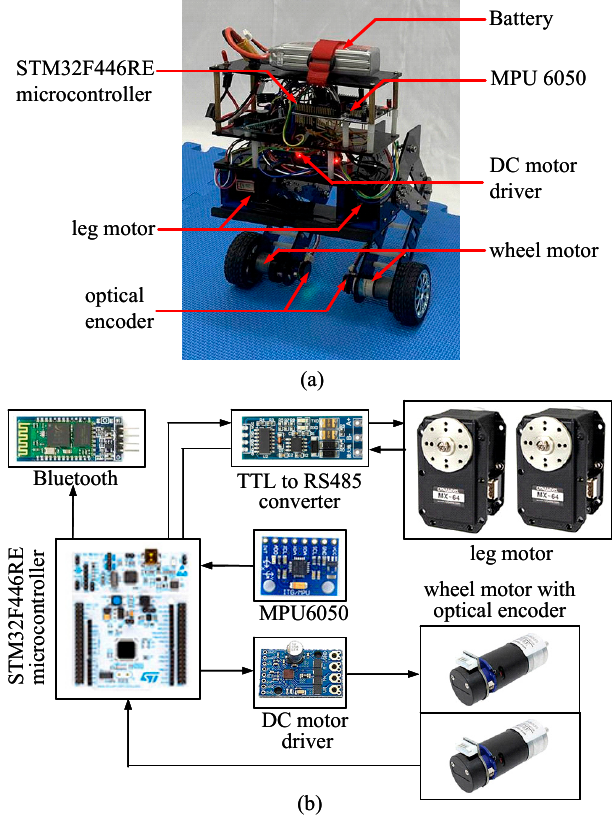
Figure 2. Photographs of the WBR. ( a ) WBR platform. ( b ) Hardware connection diagram.